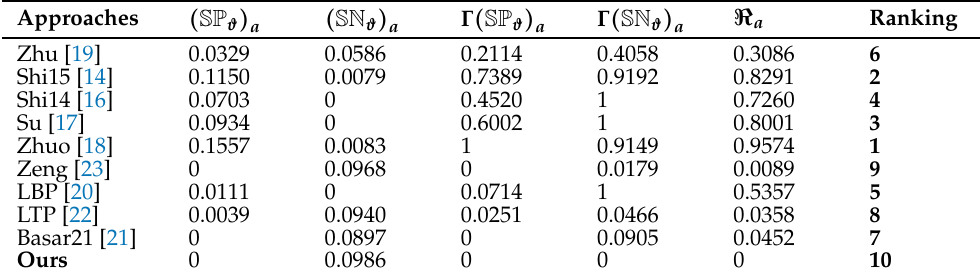
Table 10. Analysis results of 10 state-of-the-art